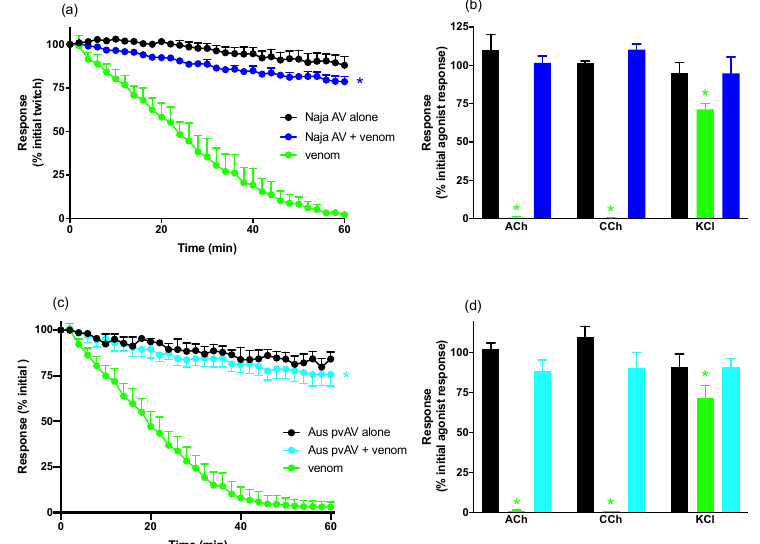
Figure 2. ( a ) The effects of N. atra venom (3 µg/mL) alone or with pre-addition of Naja atra antivenom (Naja AV; 0.75 U/mL) on indirect twitches of the CBCNM. ( b ) The effects of N. atra venom (3 µg/mL) alone or with pre-addition of Naja AV (0.75 U/mL) on contractile responses to ACh (1 mM), CCh (20 µM), and KCl (40 mM) in the CBCNM. ( c ) The effects of N. atra venom (3 µg/mL) alone or with pre-addition of Australian polyvalent antivenom (Aus pvAV; 3 U/mL) on indirect twitches of the CBCNM. ( d ) The effects of N. atra venom (3 µg/mL) alone or with pre-addition of Aus pvAV (3 U/mL) on contractile responses to ACh (1 mM), CCh (20 µM), and KCl (40 mM) in the CBCNM. * p < 0.05, significantly di ff erent compared to venom in the absence of antivenom at 60 min ( a , c ) or compared to pre-venom response to same agonist ( b , d ). n =